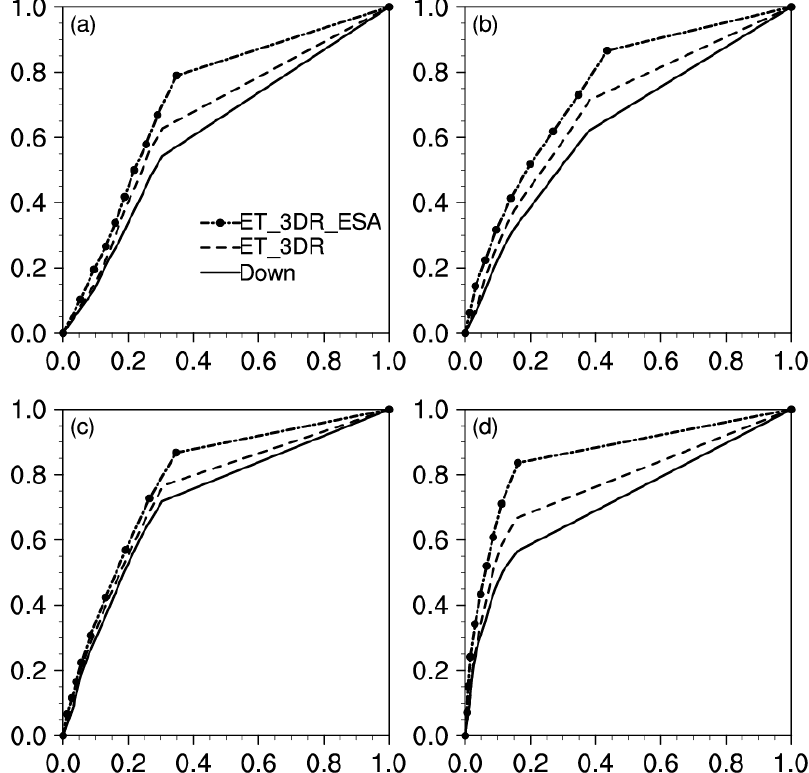
Figure 10. 12-h accumulated precipitation relative operating characteristic (ROC) curves for the three ensemble forecast systems. ( a ) light rain (0.1–5 mm), ( b ) moderate rain (5–15 mm), ( c ) heavy rain (15–30 mm), and ( d ) extreme rain (>30 mm).